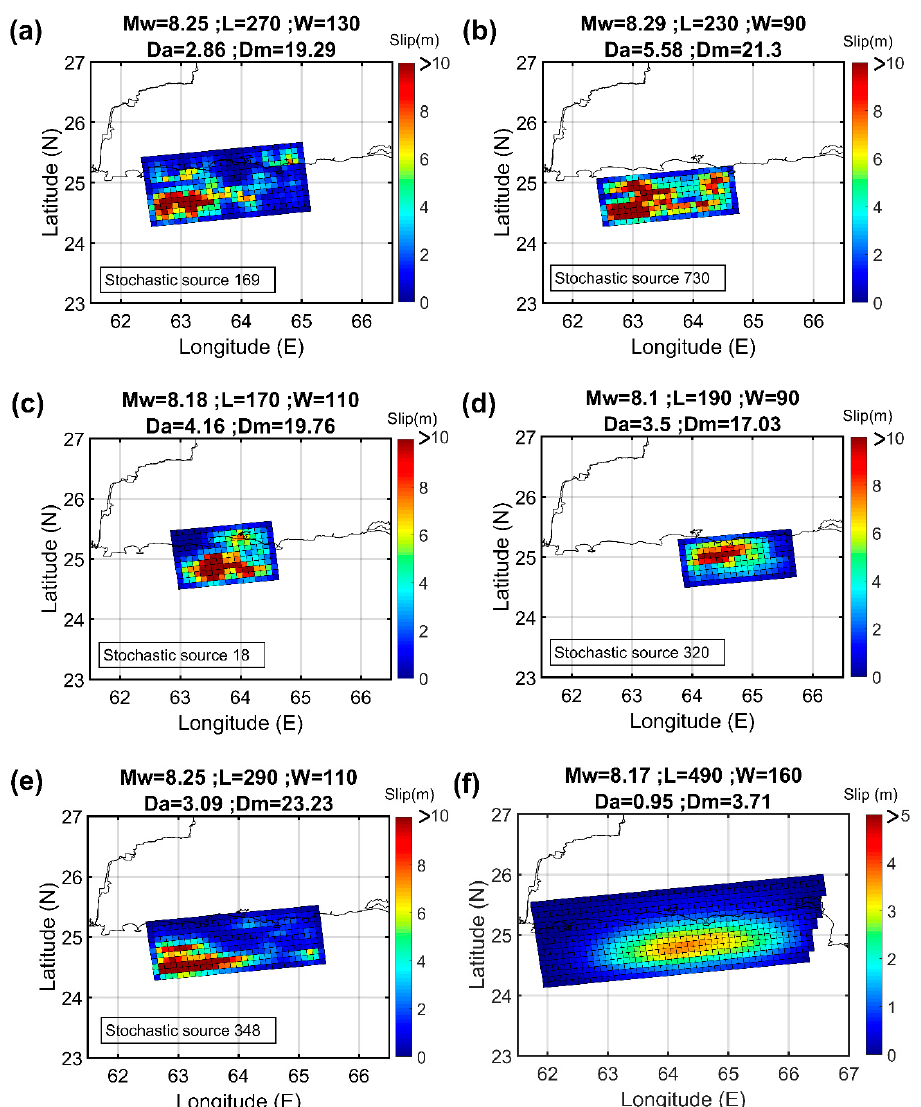
Figure 6. ( a – e ) Five stochastic source models (Mw 8.1–8.3), and ( f ) overall average slip model based on the 1000 stochastic sources (Mw 8.1–8.3) ( L : fault length, W : fault width, D a: mean slip, D m: 1000 stochastic sources (Mw 8.1–8.3) ( L : fault length, W : fault width, D a : mean slip, D m : maximum maximum slip).